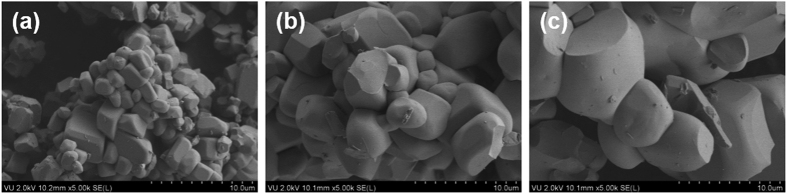
SEM images.(a) Y2Mo4O15, (b) Y2Mo4O15:50%Eu3+, and (c) Y2Mo4O15:75%Eu3+ under magnification of 5.0 k.